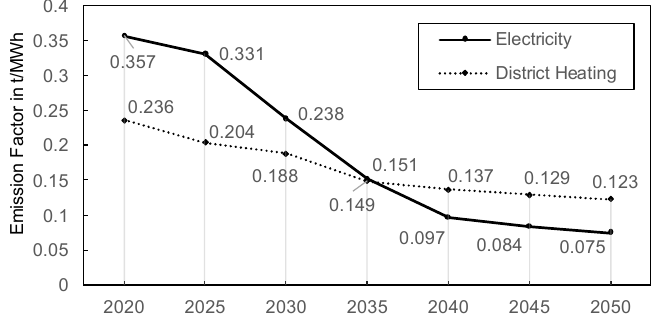
Figure 5. Emission factor of electricity (mix) in tons of CO 2 per MWh; combined heat and power (CHP) allocation method: Carnot.